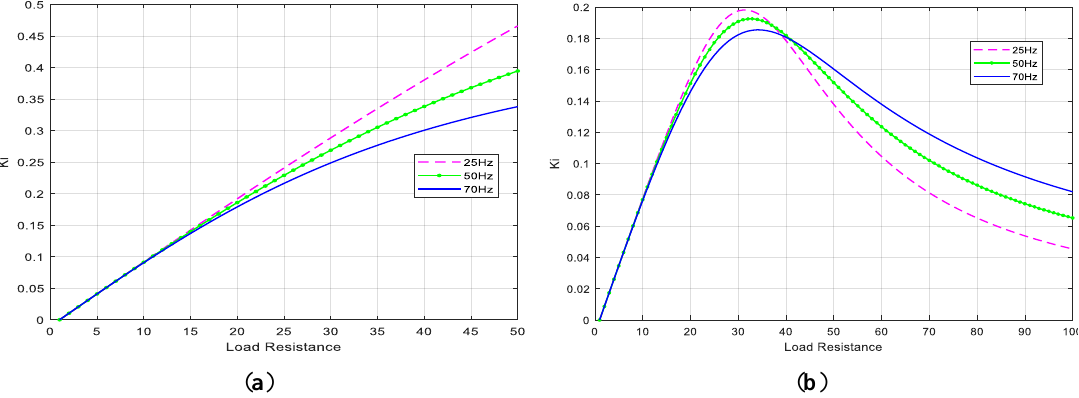
Figure 12. Static characteristics of current gain as a function of increasing load: ( a ) Venturini modulation for q = 0.5, ( b ) SVM for q = 0.866 and φ i = 0 .